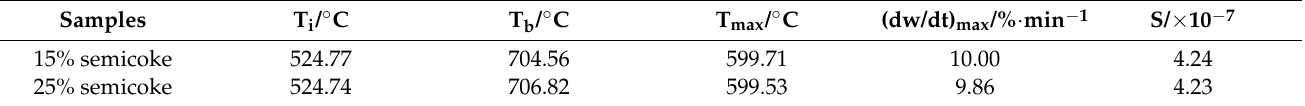
Table 3. Combustion characteristic parameters of the mixture of semicoke and bituminous coal with different addition ratios.